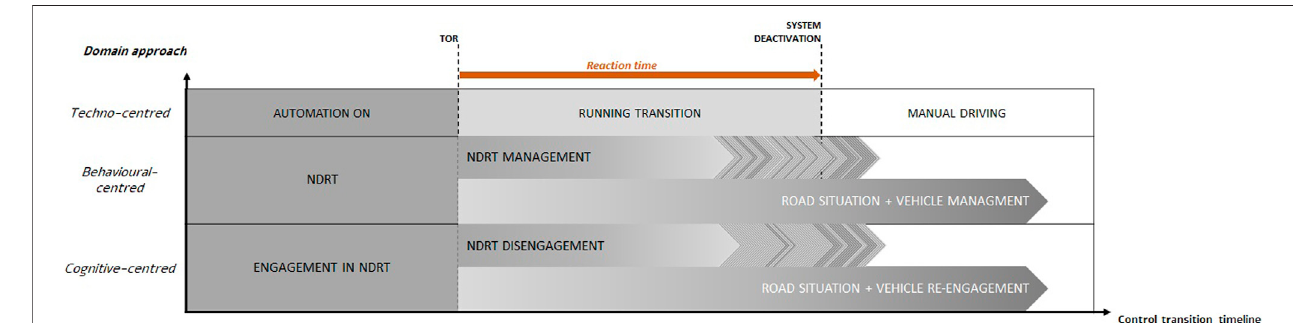
FIGURE 4 | Illustration of different ways to investigate a control transition, from system to driver.